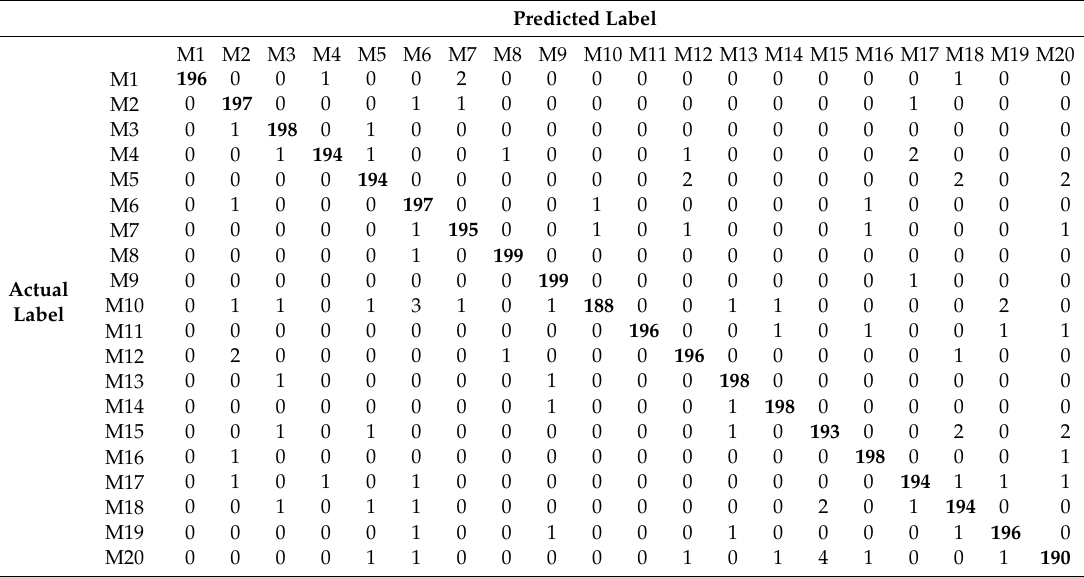
Table 8. The classification accuracy of 20 motions with the bilinear